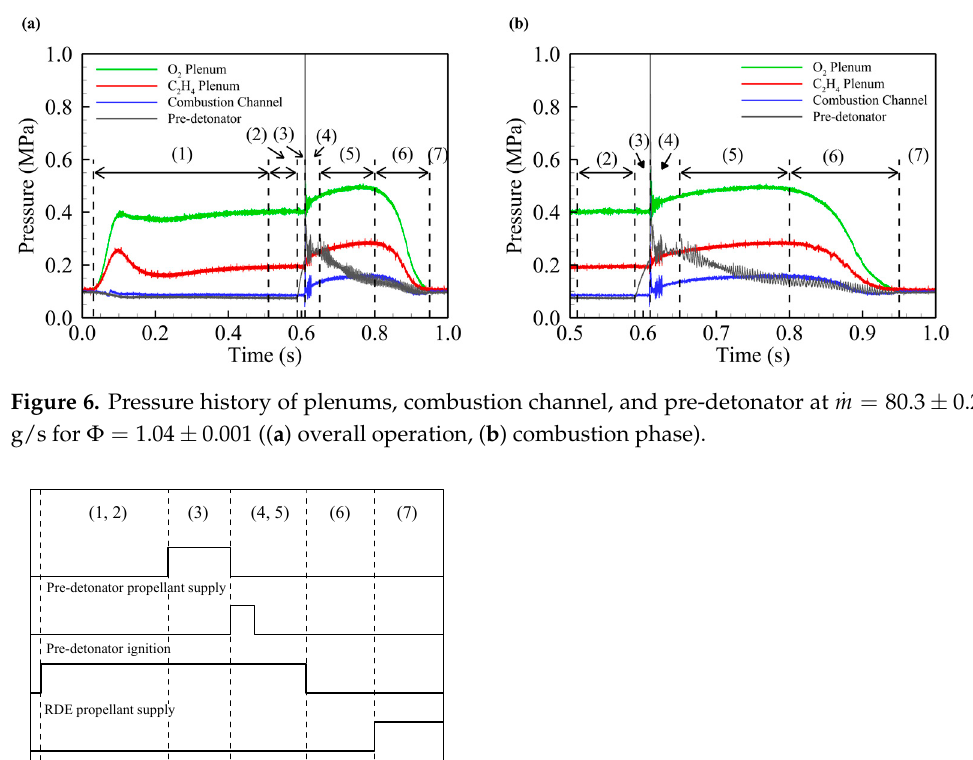
Figure 7. RDE hot fire test sequence programmed in the PLC.